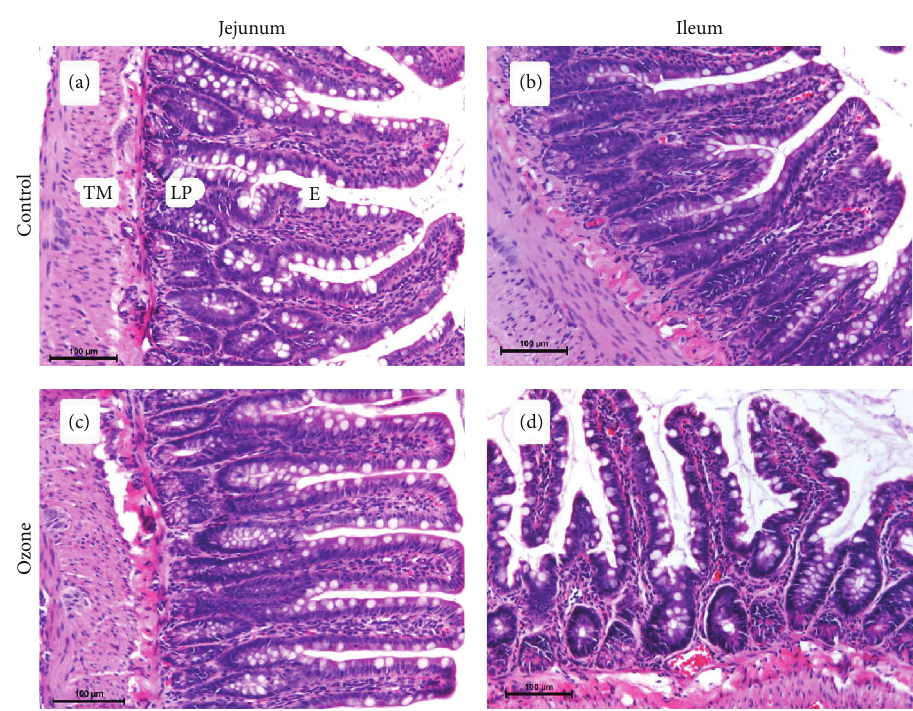
Figure 1: Effect of ozone in jejunum and ileum (stained with hematoxylin-eosin, magnification × 200). Normal intestinal histology of jejunum and ileum in both control (a, b) and ozone groups (c, d). TM: tunica muscularis, LP: lamina propria, E: enterocyte.